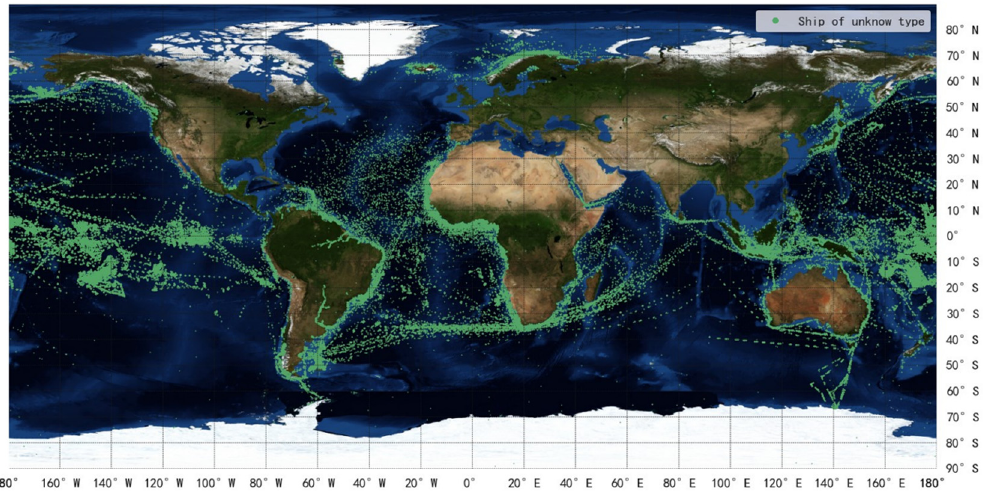
Figure 1. Ships’ distribution with type unknown in message1.